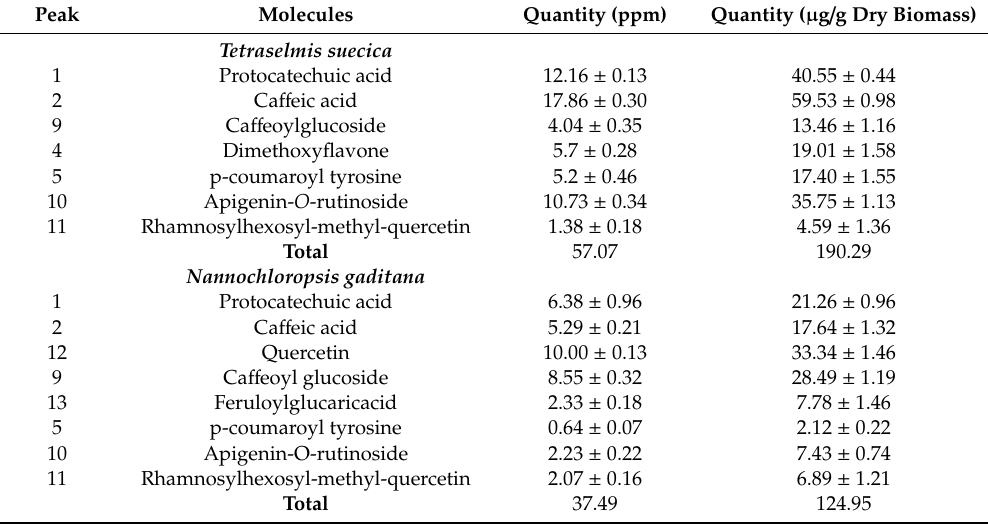
Figure 2. LC–MS (ESI - ) profile ofp-coumaroyl tyrosine from P. tricornutum ( A ) and dimethoxyflavone from T. suecica species ( B ). 2.4. Determination of the Carotenoids in the Microalgae Species 2.4.1. Identification of Carotenoids The analysis of carotenoids from both the dried biomass and crude liquid of the four microalgae samples was carried out through a C30 column within 60 min; xanthophylls, chlorophylls, and hydrocarbon carotenoids were identified (Figure 3). LC–PDA–MS was employed for identification of carotenoids, listed in Table 5. Based on the UV-vis and mass spectra interpretation, four different groups of carotenoids were determined: (i) Ketocarotenoids group represented by Echinone; (ii) hydroxy-carotenoids group expressed by vaucheriaxanthin, cis-15-lutein, cis-13-lutein, all-E-lutein, cis-prasinoxanthin, andzeaxanthin; (iii) carotenes represented by β -carotene and 9-cis- β -carotene; and (iv)